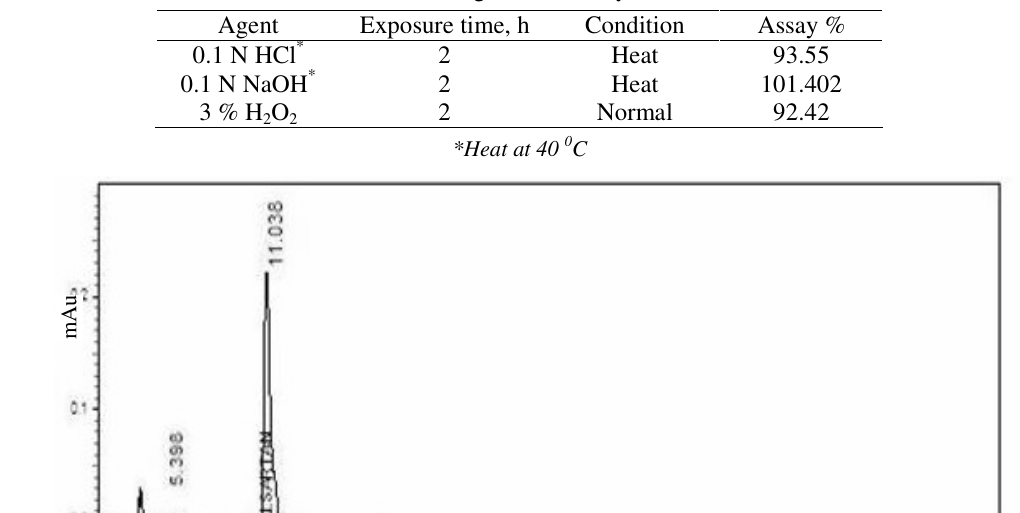
Table 5. Forced degradation study of valsartan.